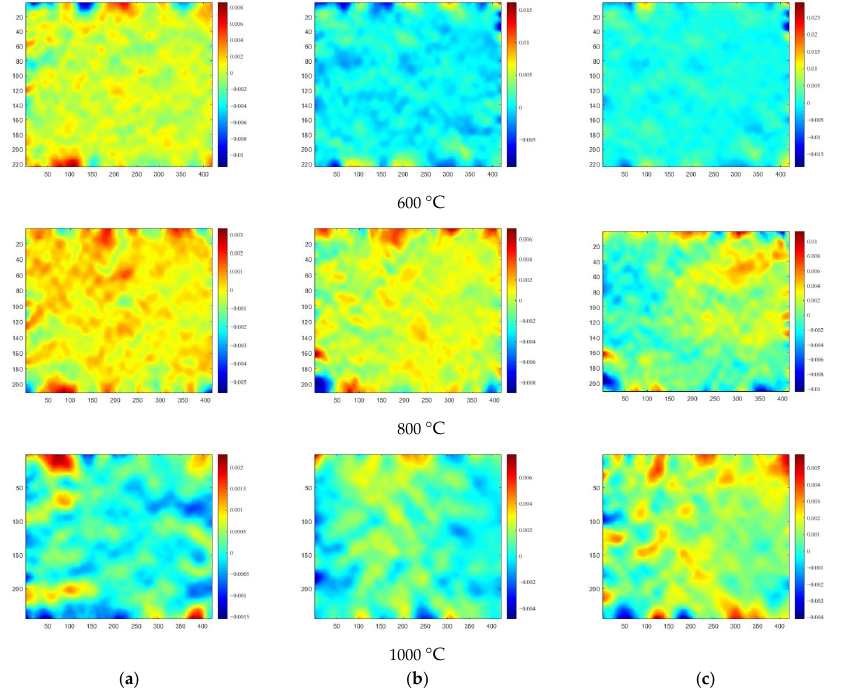
Figure 14. Vertical strain clouds of sandstone specimens after different temperatures under impact loading. ( a ) Initial loading period. ( b ) Mid-loading period. ( c ) Later loading period.